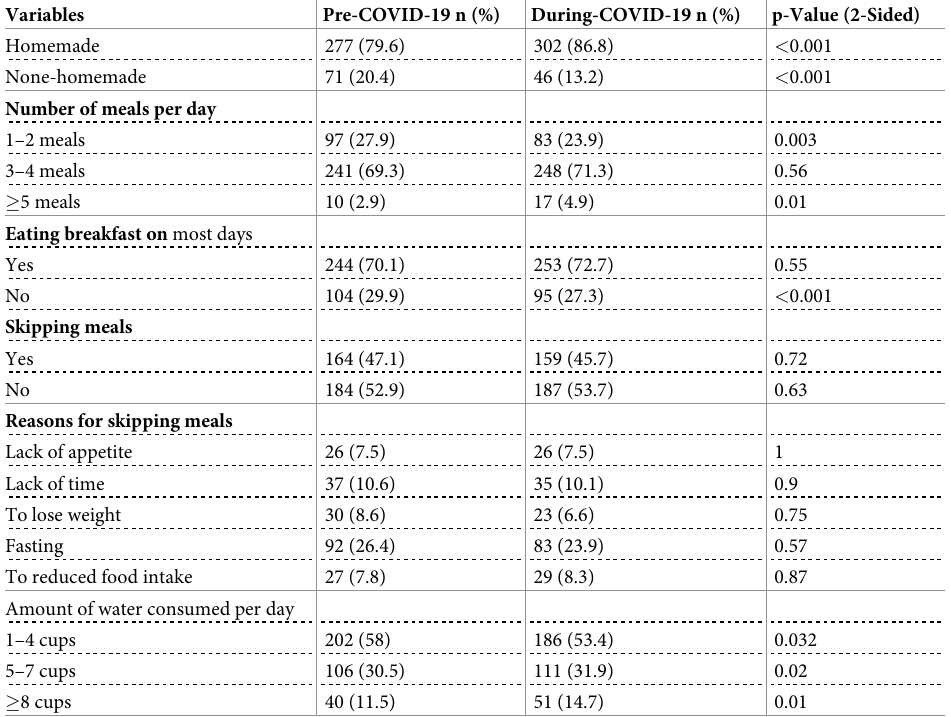
Table 3. Eating habits pre- and during COVID-19 pandemic (n = 348).